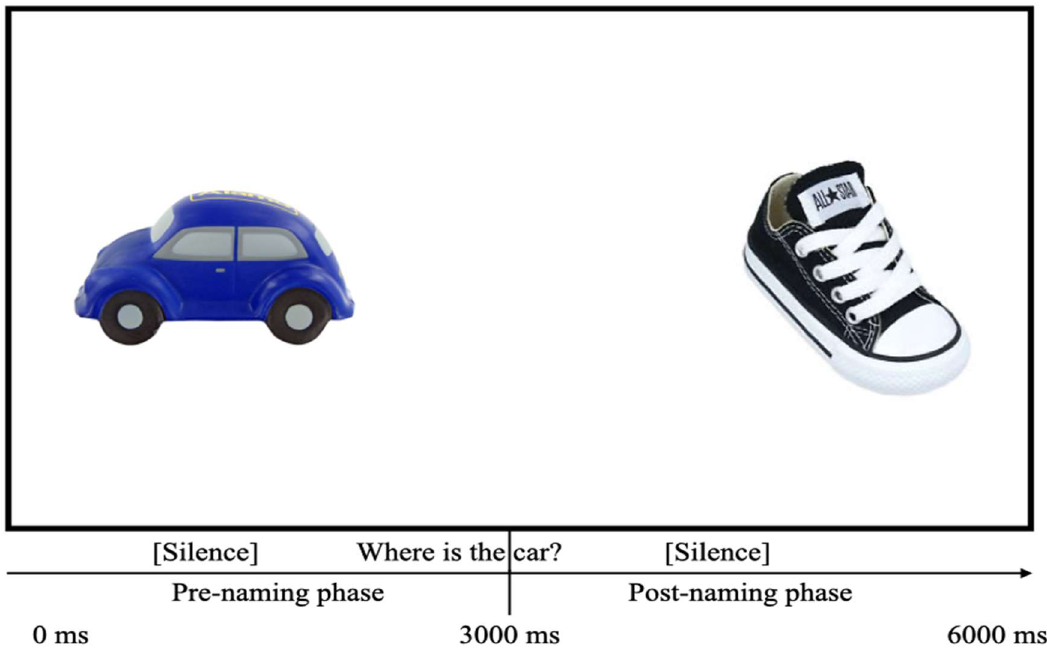
Figure 1. Structure of a sample trial from the lexical processing looking-while-listening (LWL) paradigm.